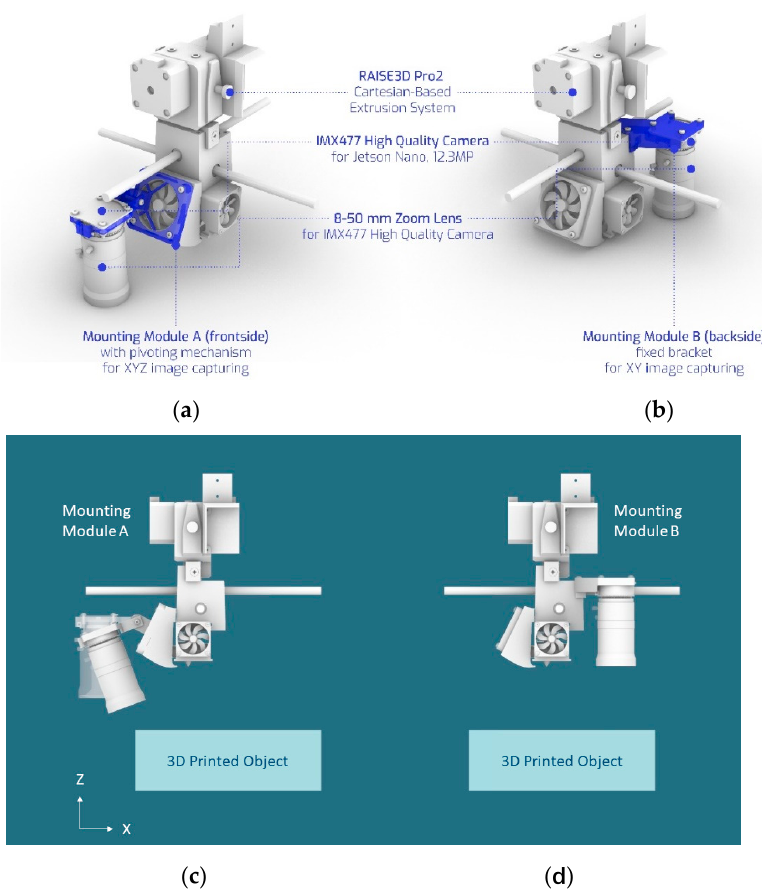
Figure 1. Design of customizable tools for detection (i.e., image capturing) devices integration: ( a ) Mounting Module A (frontside) with pivoting mechanism for XYZ image capturing; ( b ) Mounting Module B (backside) fixed bracket for XY image capturing. ( c ) Mounting Module A rotating on XZ plane and around the offset Y axis set on the bolted pivoting mechanism; ( d ) Mounting Module B fixed perpendicular to the XY plane.